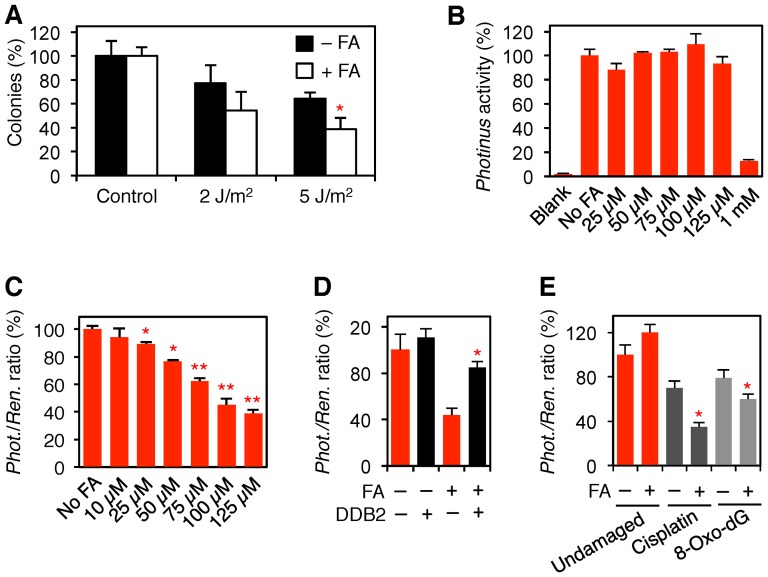
Inhibition of NER and BER activity by low-dose formaldehyde.(A) Colony-forming assay demonstrating that human fibroblasts exposed to formaldehyde (75 μM) are more sensitive to killing by UV radiation (2 and 5 J/m2) than the respective untreated controls (error bars, S.D.; n = 3, each measurement in triplicate). The asterisk (*p<0.05) denotes the significantly reduced colony formation ability. (B) Expression of Photinus luciferase in cells containing undamaged pGL3 and exposed (18 h) to formaldehyde. All values (N = 3; error bars, S.D.) are shown as a percentage of luciferase activity in untreated fibroblasts. Blank, untransfected cells. (C) Host-cell reactivation of UV-irradiated pGL3 reflecting NER activity in cells exposed (18 h) to formaldehyde. Values (N = 10; error bars, S.D.) are shown as a percentage of the Photinus/Renilla ratio in control cells. Asterisks, significant differences from the control (*p<0.05, **p<0.01). (D) Partial restoration of host-cell reactivation in 100-μM formaldehyde-treated cells overexpressing DDB2-EGFP (N = 5). Asterisk, significantly (*p<0.05) higher NER activity then controls without DDB2-EGFP. (E) Inhibition of host-cell reactivation of pGL3 containing cisplatin adducts or 8-oxo-dG lesions (N = 5). The asterisks (*p<0.05) denote significantly reduced DNA repair activity in formaldehyde-treated (75 μM, 18 h) cells.